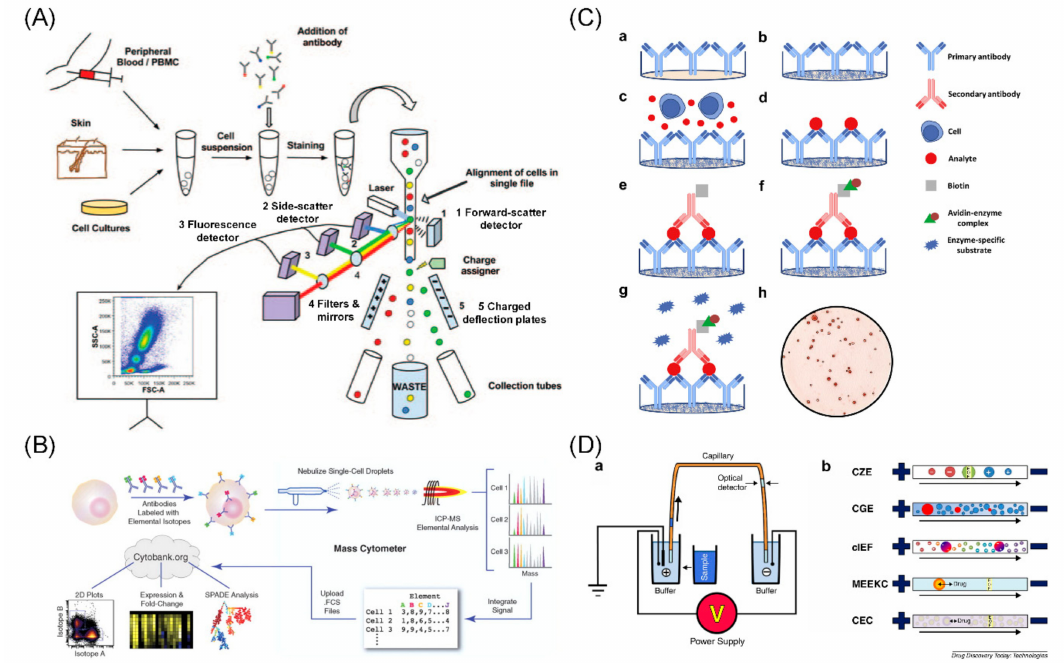
Figure 1. Schematics of conventional approaches for single-cell protein analysis. ( A ) Fluorescence flow cytometry. Single cells stained with fluorescent labelled antibodies rapidly travel through the flow chamber, stained cells are excited by a laser, and the emitted fluorescent intensities are measured by the detector. Additionally, the fluorescent intensities could reflect the single-cell proteins expression. Adapted with permission from [22]. ( B ) Mass cytometry. Stained single cells with element isotopes labelled antibodies are pushed into a nebulizer and ionized, and an elemental mass spectrum is acquired for each cell. The integrated elemental reporter signals for each cell can then be analyzed by flow cytometry. Adapted with permission from [27]. ( C ) Enzyme-linked immunospot. Single cells are localized on a plate coated with capture antibodies against specific secreted proteins. When the cells secrete proteins after stimulation, the secreted proteins are captured by the primary antibody and the signal is further amplified by secondary antibody. Each visual spot signal readout represents a single cell expressing the target protein and intensity of spot indicates proteins secretion level. Adapted with permission from [28]. ( D ) Capillary electrophoresis. Single cells are injected into the capillary under electromigration or pressure and then lysed via chemical, optical, or electrical methods resulting in lysed ions of diverse levels of migration properties. Combined with electrochemical, laser induced fluorescence, mass spectrometry, and other technologies, the detector outputs an electrophoretic spectrum which can reflect the protein expression. Adapted with permission from